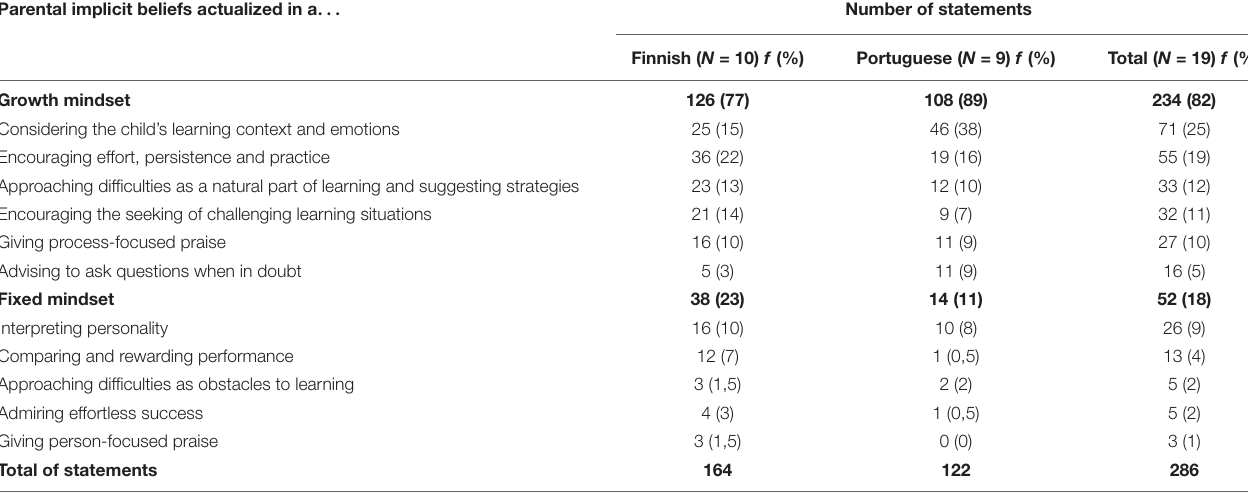
TABLE 3 | Actualization of parents’ implicit beliefs about learning in their parental engagement at home. Parental implicit beliefs actualized in a